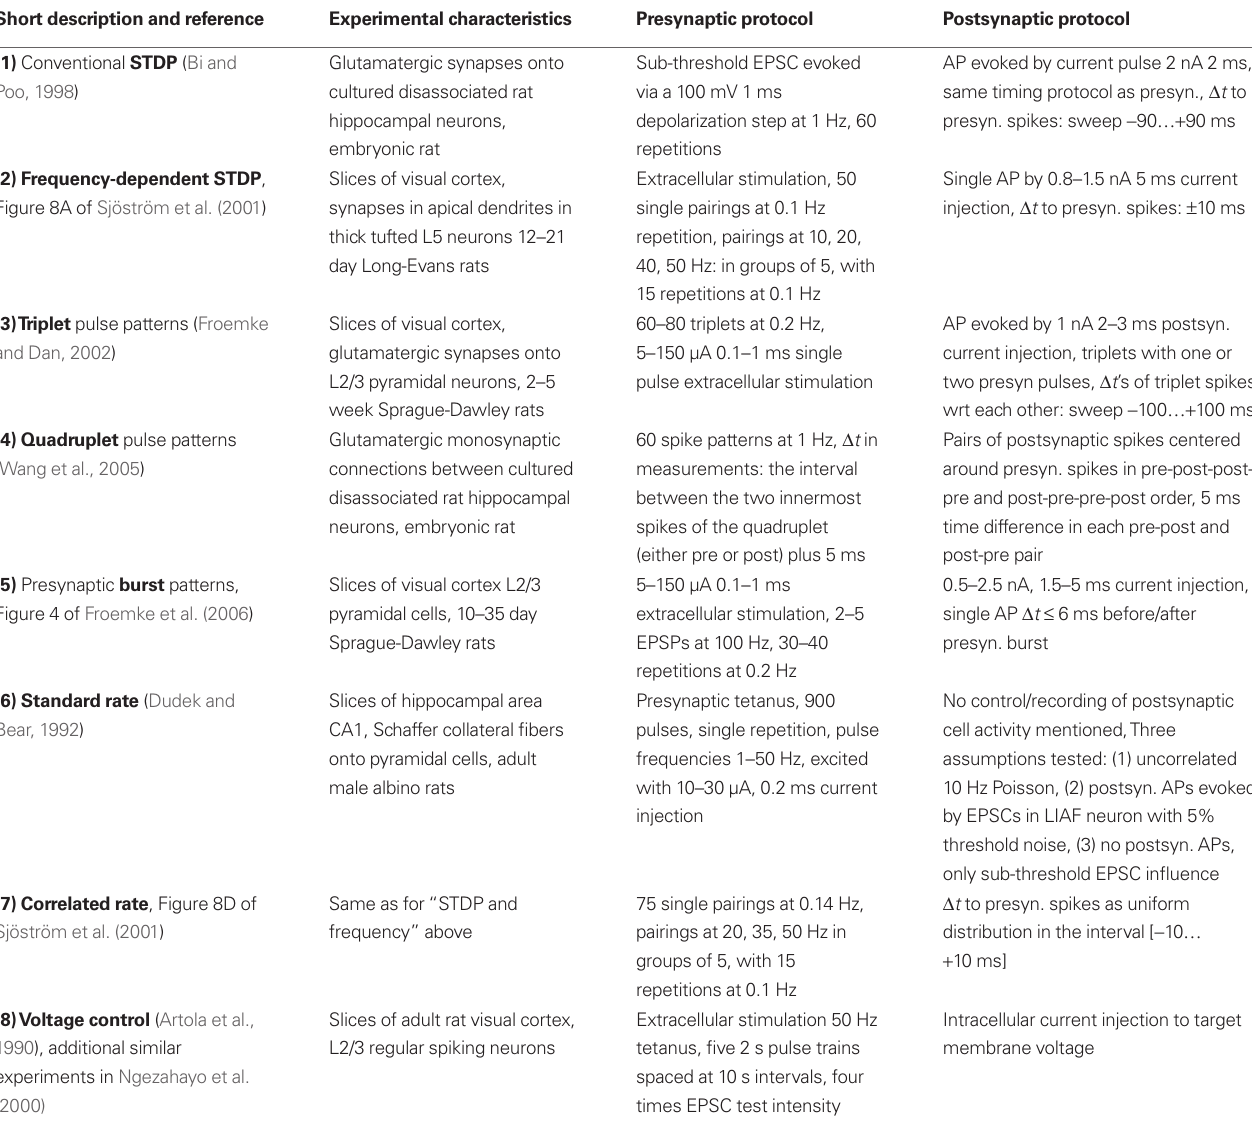
Table 1 | Listing of plasticity experiments, the numbers and keywords assigned in bold font to the single experiments are used for later reference in the